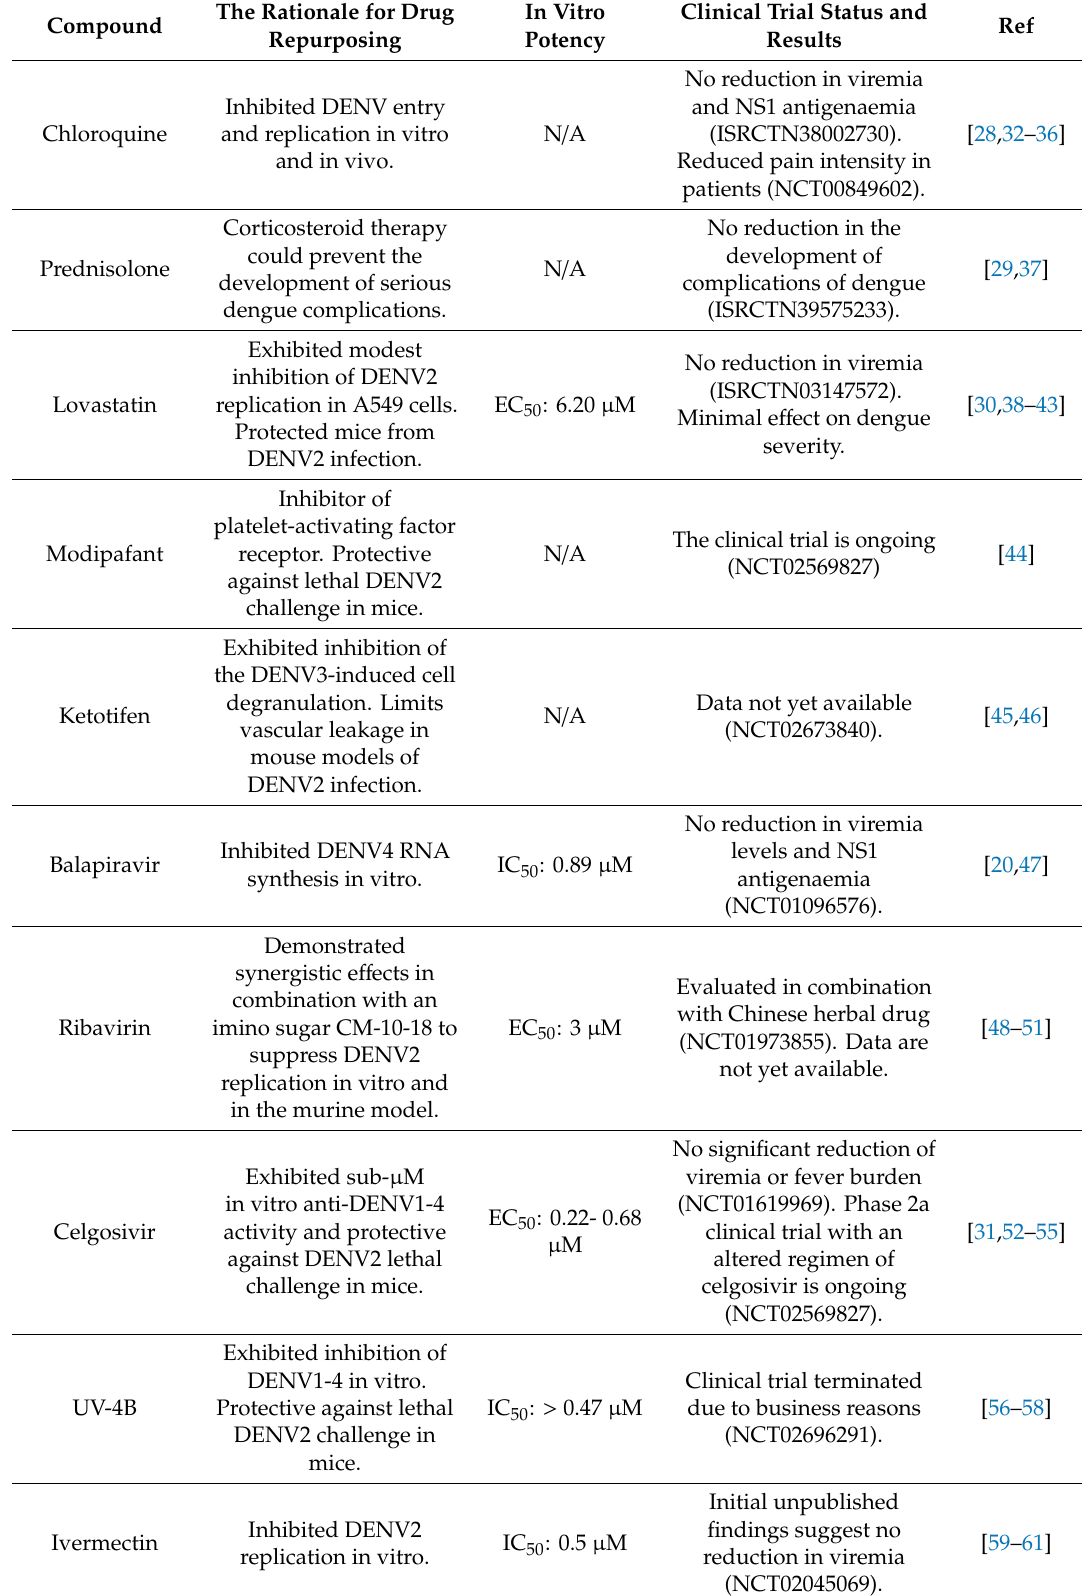
Table 1. Repurposed drugs evaluated in clinical